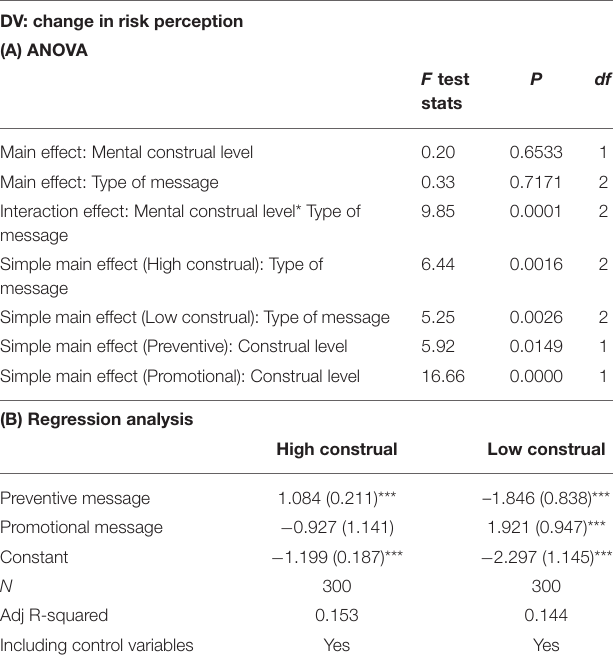
TABLE 2 | Testing for the effects of mental construal, technology messaging type, and their interaction on the response. DV: change in risk